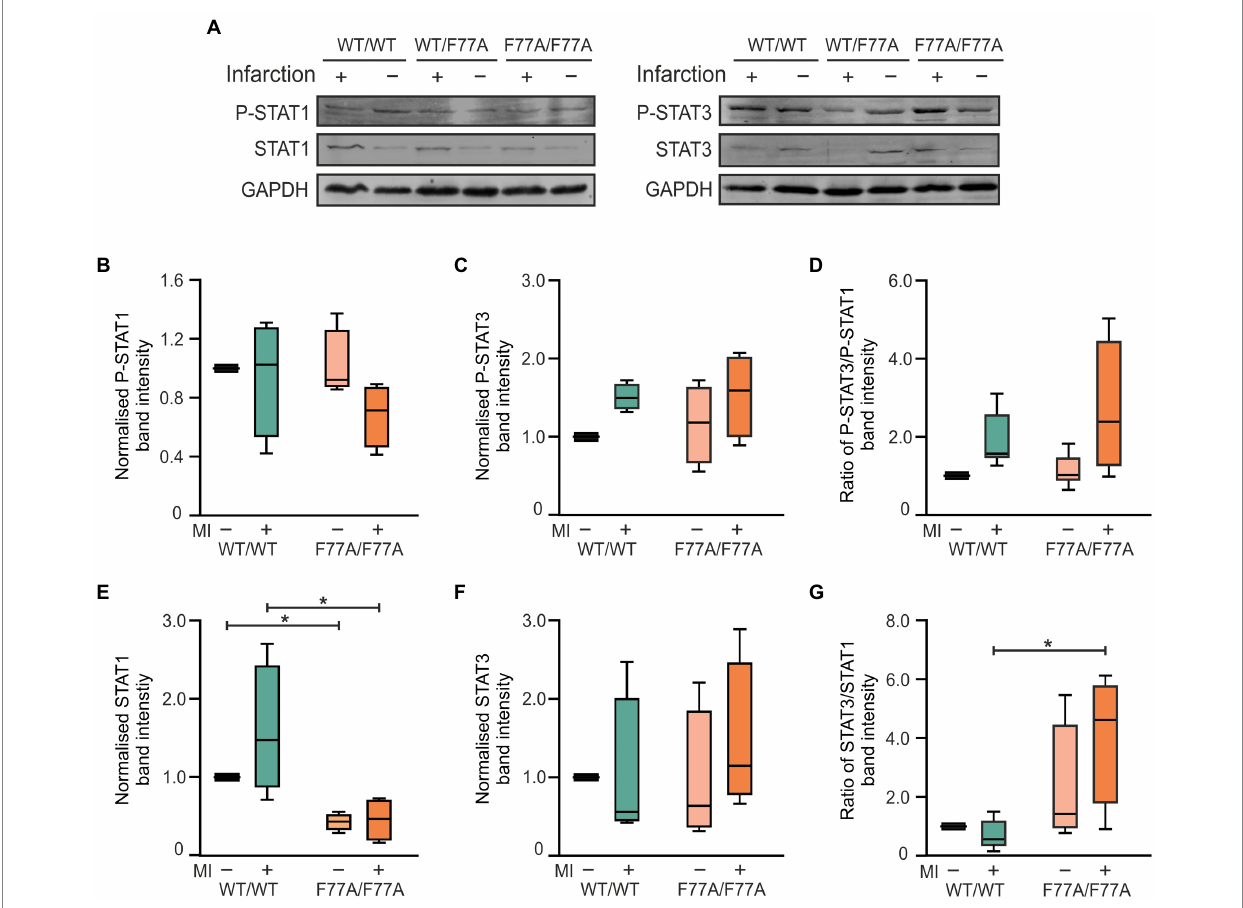
FIGURE 2 Increased ratio of total STAT3 to STAT1 level in the myocardium of mice expressing homozygously the STAT1-F77A mutation on day 3 after MI. (A) Representative Western blots of proteins extracted from either infarcted ventricular tissue (+) or unaffected areas (−) from the ventricles of mice carrying the WT/WT, WT/F77A and F77A/F77A genotypes. Blots were probed with anti-phosphotyrosine STAT1 (p-STAT1), anti-pan STAT1 (STAT1), anti- phospho-STAT3 (p-STAT3) and anti-pan STAT3 antibodies, as well as a GAPDH-specific antibody (GAPDH) used for normalization (see also Supplementary Figure 3). (B – G) Quantification of immunoblots from three independent experiments, as shown in (A) and standardized to the WT non- infarcted value. Only the α -forms of STAT1 and STAT3 were evaluated. Asterisks in the box plots indicate statistically significant differences, as determined using t- test. All WT bands were normalized to